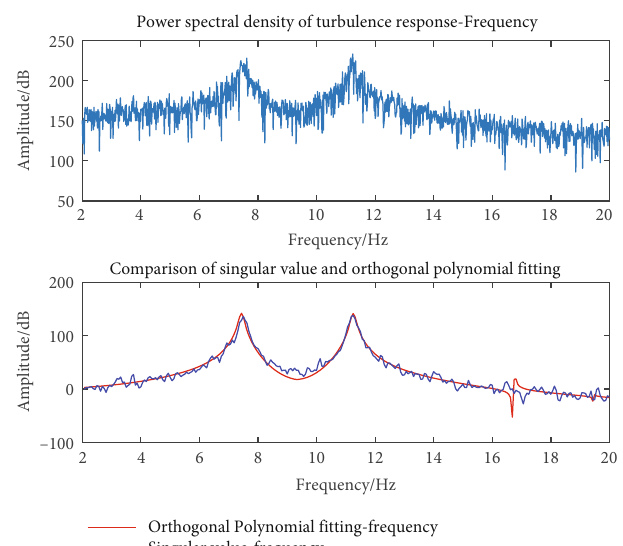
Figure 8: System identi fi cation result.